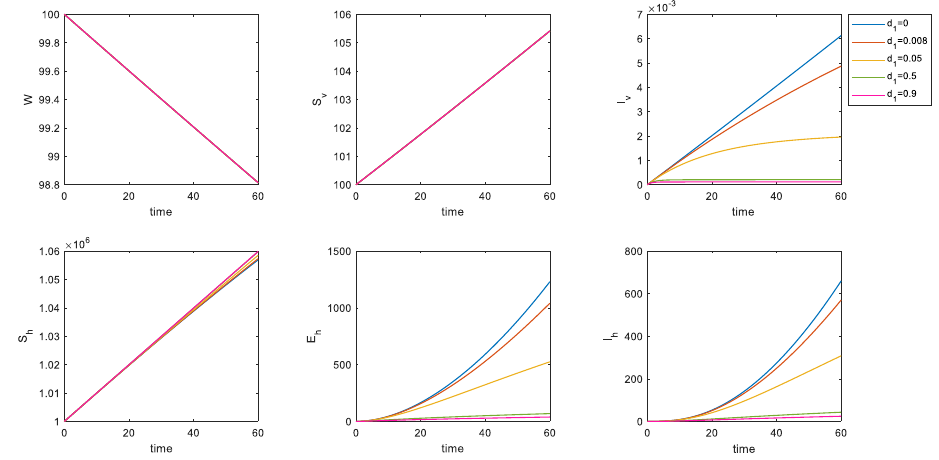
Figure 9. Changes in the numbers of W , S v , I v , S h , E h , and I h with different d 1 in model 2.